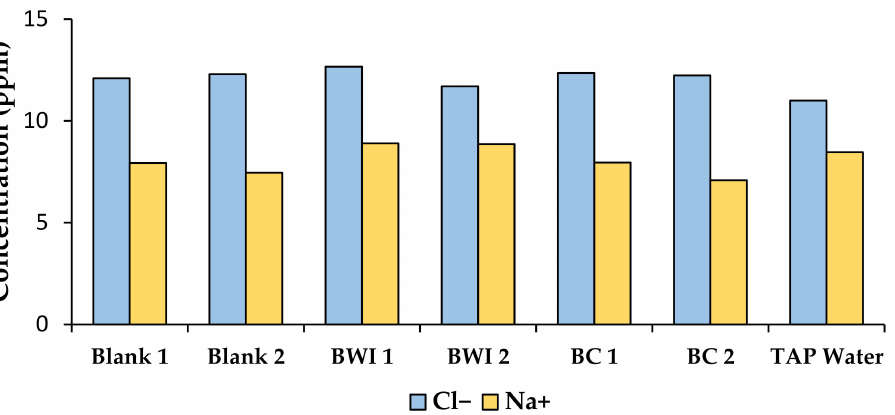
Figure 5. Concentration of sodium and chloride ions in tap water for all columns prior to the introduction of plants (blank: no plants; BWI: Blue Wild Indigo; BC: Broadleaf